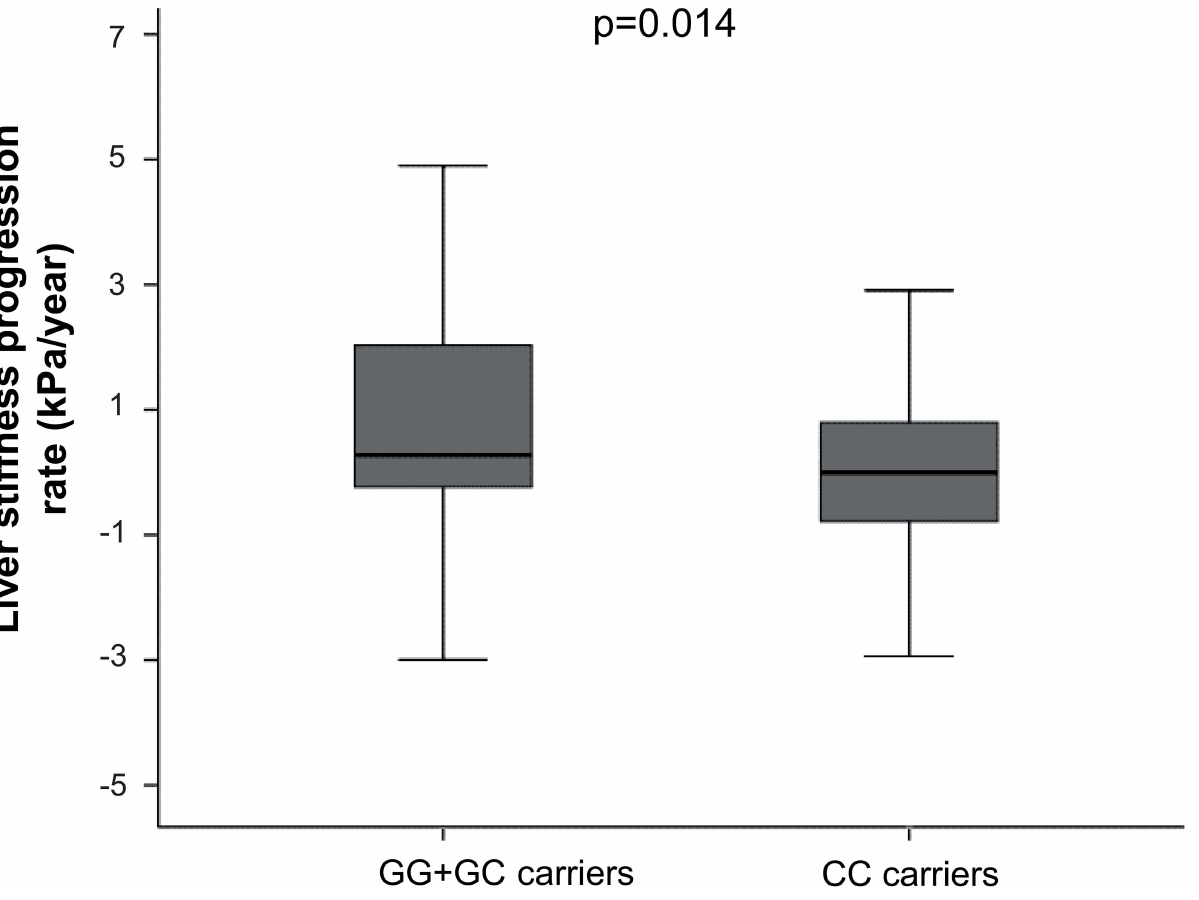
Fig 1. Liver stiffness progression rate according to PNPLA3